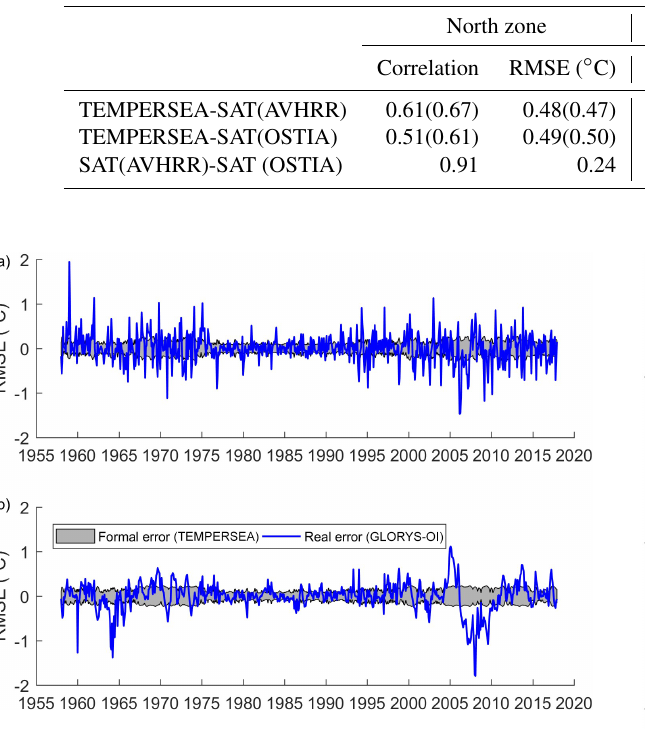
Figure 9. Comparison of the formal error of the temperature av- erage in the North zone with the true error when the algorithm is applied to synthetic data. Results shown for (a) 7m depth and (b) 125m depth.